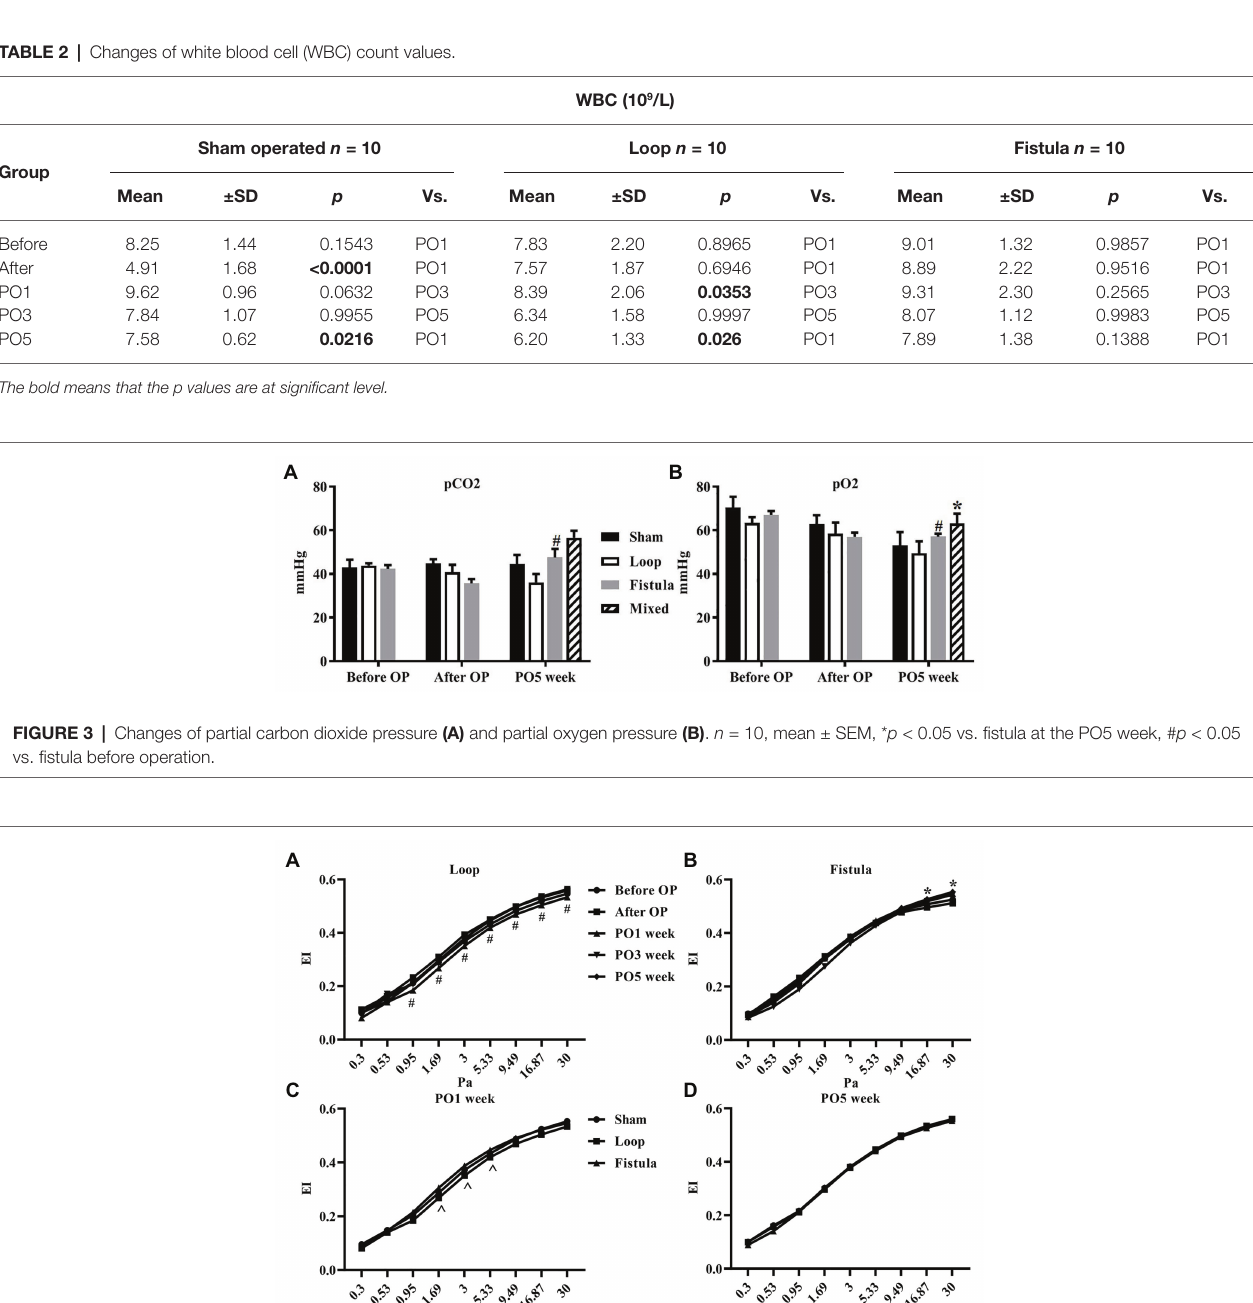
FIGURE 4 | Changes of red blood cell deformability (elongation index values in the function of shear stress) in the loop group (A) , fistula group (B) , all groups at the PO1 week (C) , and all groups at the PO5 week (D) . n = 10, mean ± SEM, # p < 0.05 vs. PO3 week and PO5 week, * p < 0.05 vs. before operation, ^ p < 0.05 vs. sham and loop group.